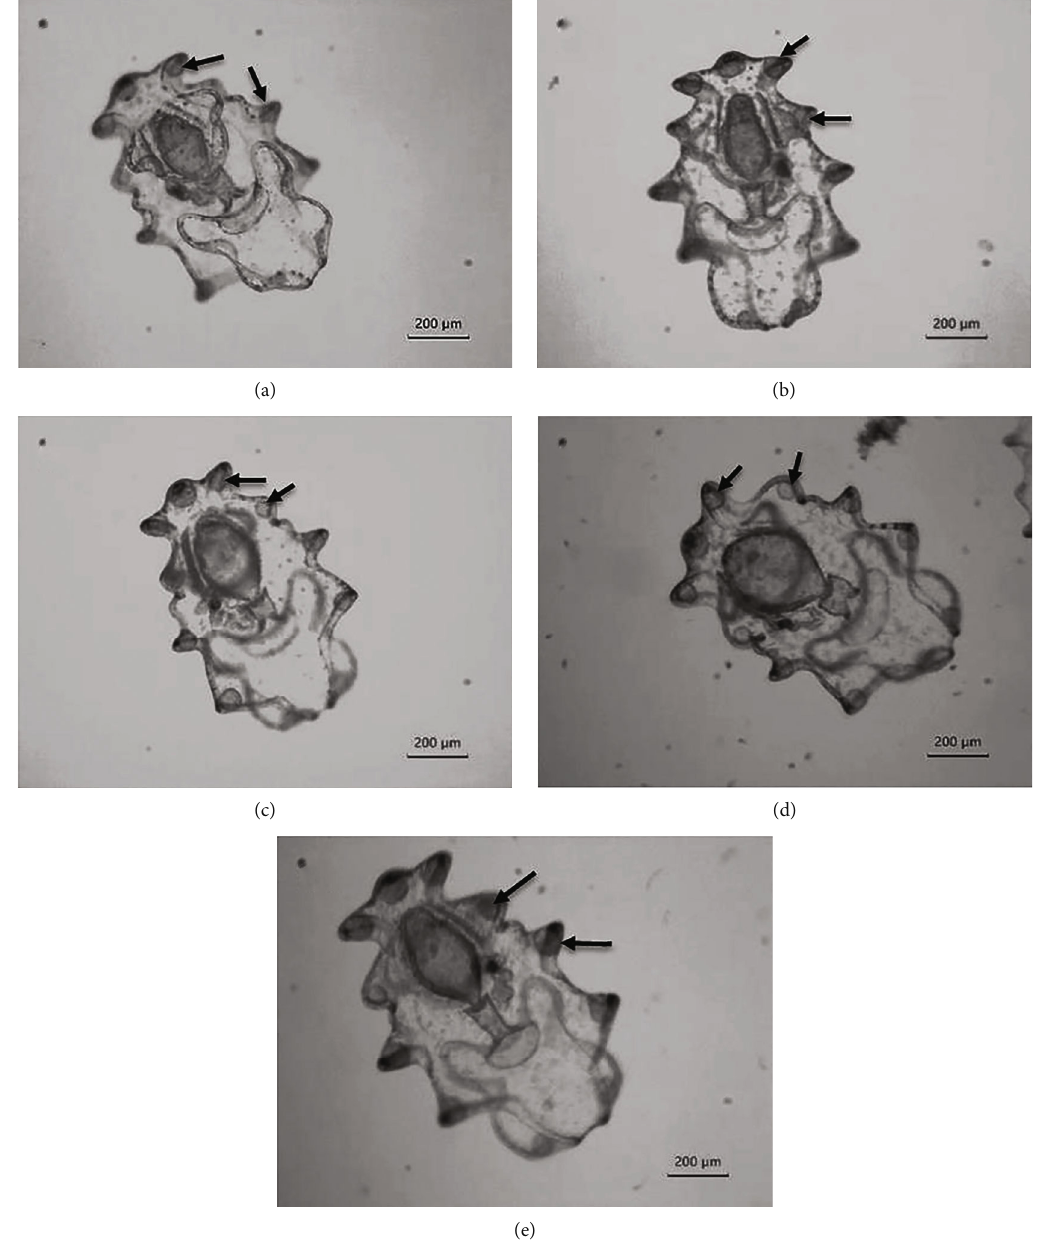
Figure 4: Late auricularia larvae of Holothuria leucospilota on day 15 in di ff erent diet treatments: (a) A, (b) B, (c) C, (d) D, and (e) E. Arrows indicate hyaline